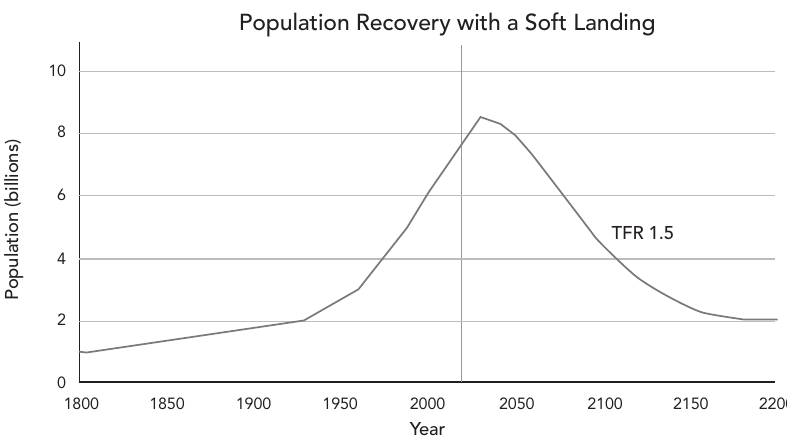
Figure 2. Population Recovery with a Soft Landing – prospects for population decline through achieving a TFR of 1.5 by